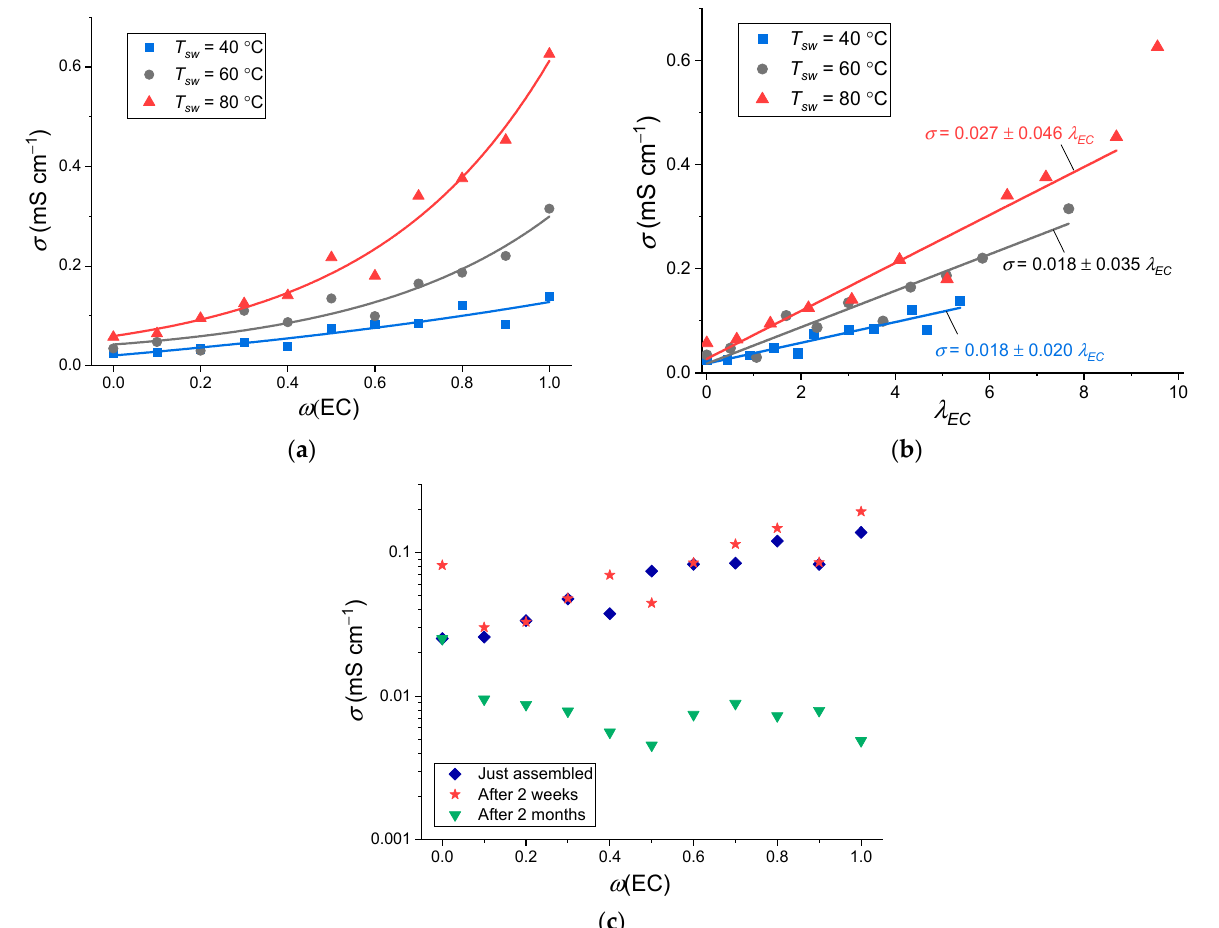
Figure 7. Ionic conductivity of the membranes at 30 °C for Na-Nafion membranes swollen at various temperatures as a function of ( a ) ω (EC) and ( b ) λ EC ; ( с ) ionic conductivity of the membranes at 30 °C at various measurement times ( T sw = 40 °C).